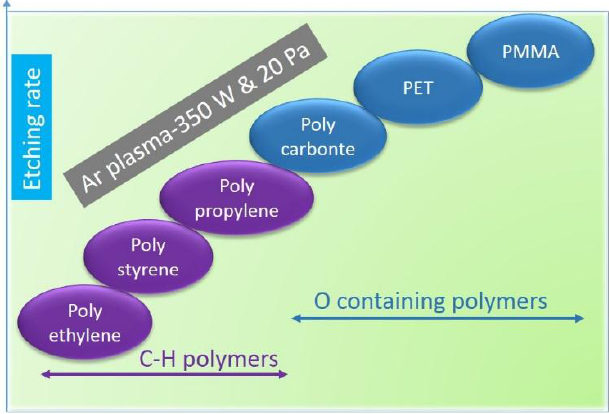
Figure 6. Etching rates for various polymer substrates in Ar plasma based on [81]